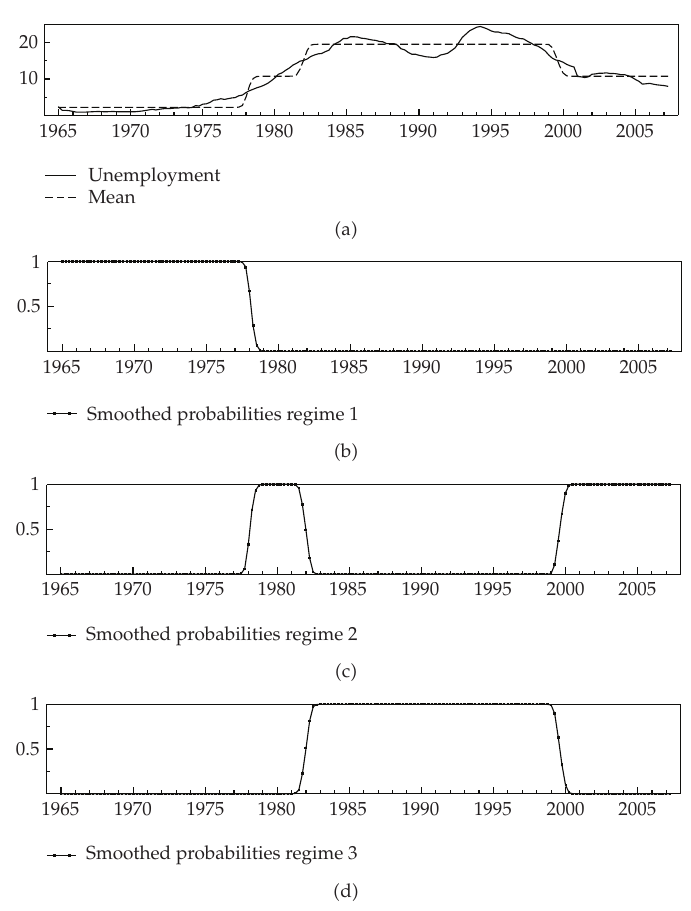
Figure 2: Unemployment and regime probabilities for